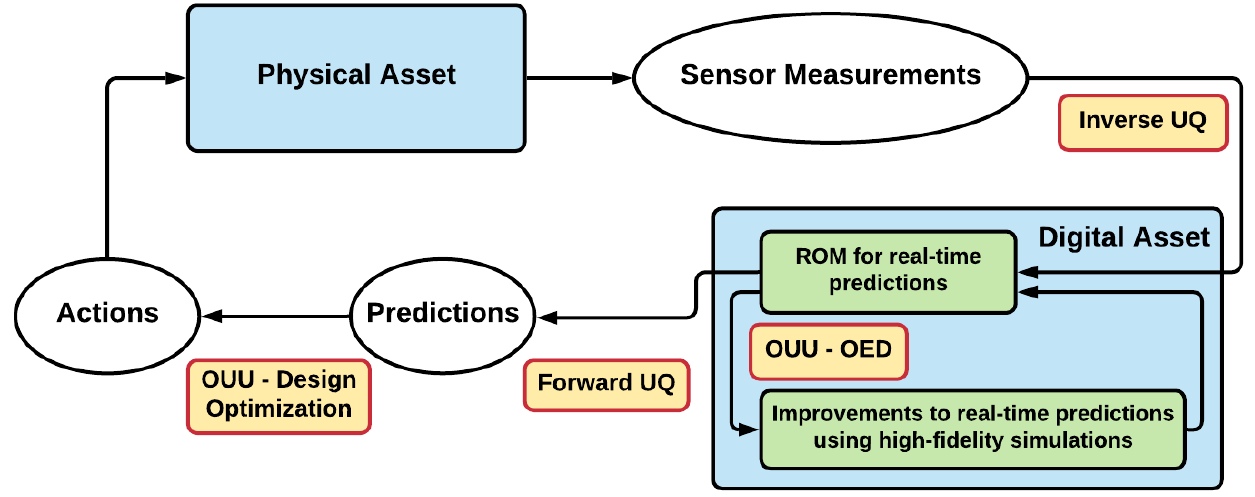
Figure 8. UQ tasks (yellow boxes) in the context of a